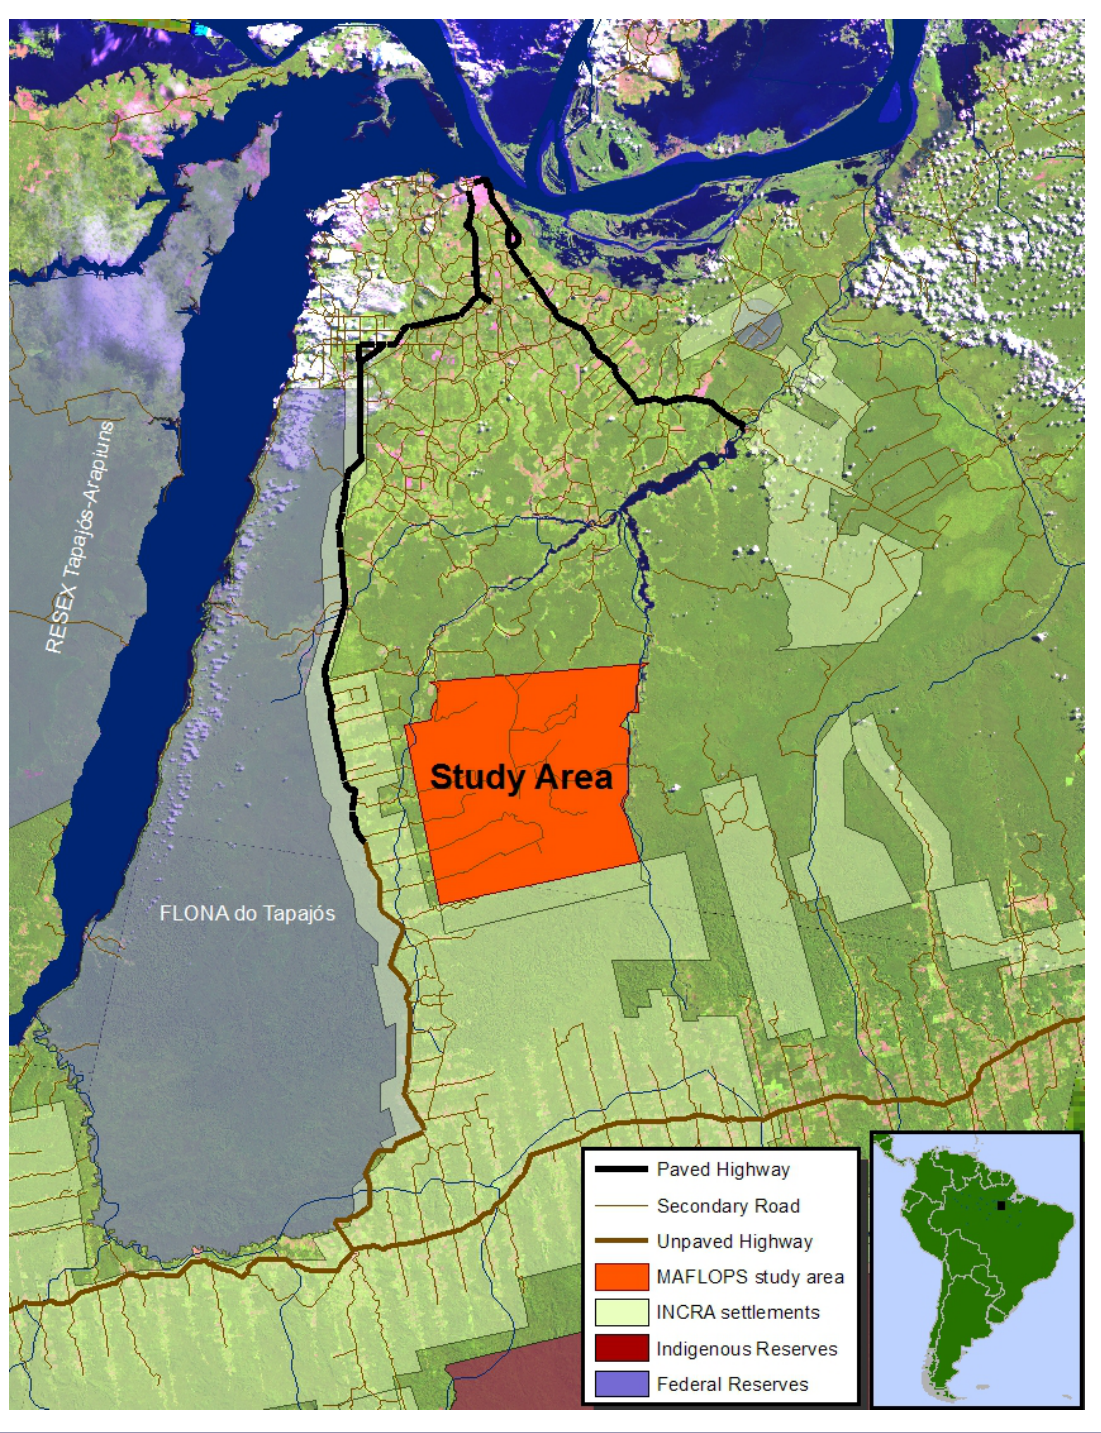
Fig. 1. Study site and